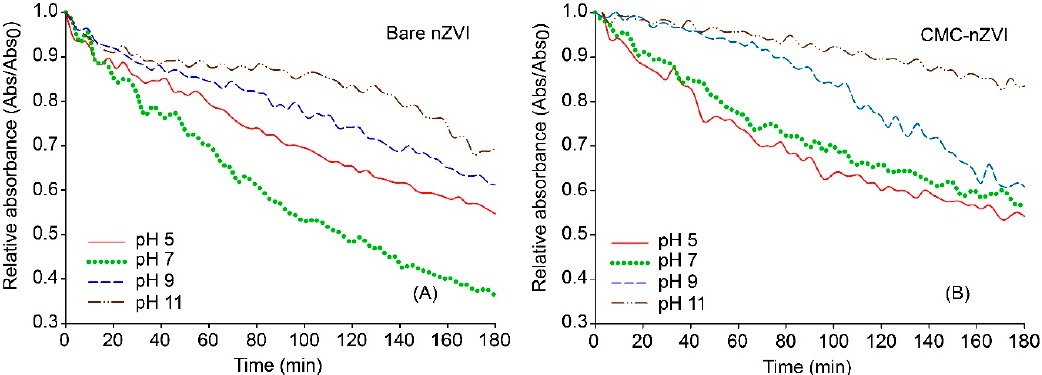
Figure 5. Effect of pH on the stability bare nZVI, (A); and CMC–nZVI, (B), of 0.1 g L − 1 nZVI suspensions in 1 mM NaHCO 3 . in 1 mM NaHCO 3